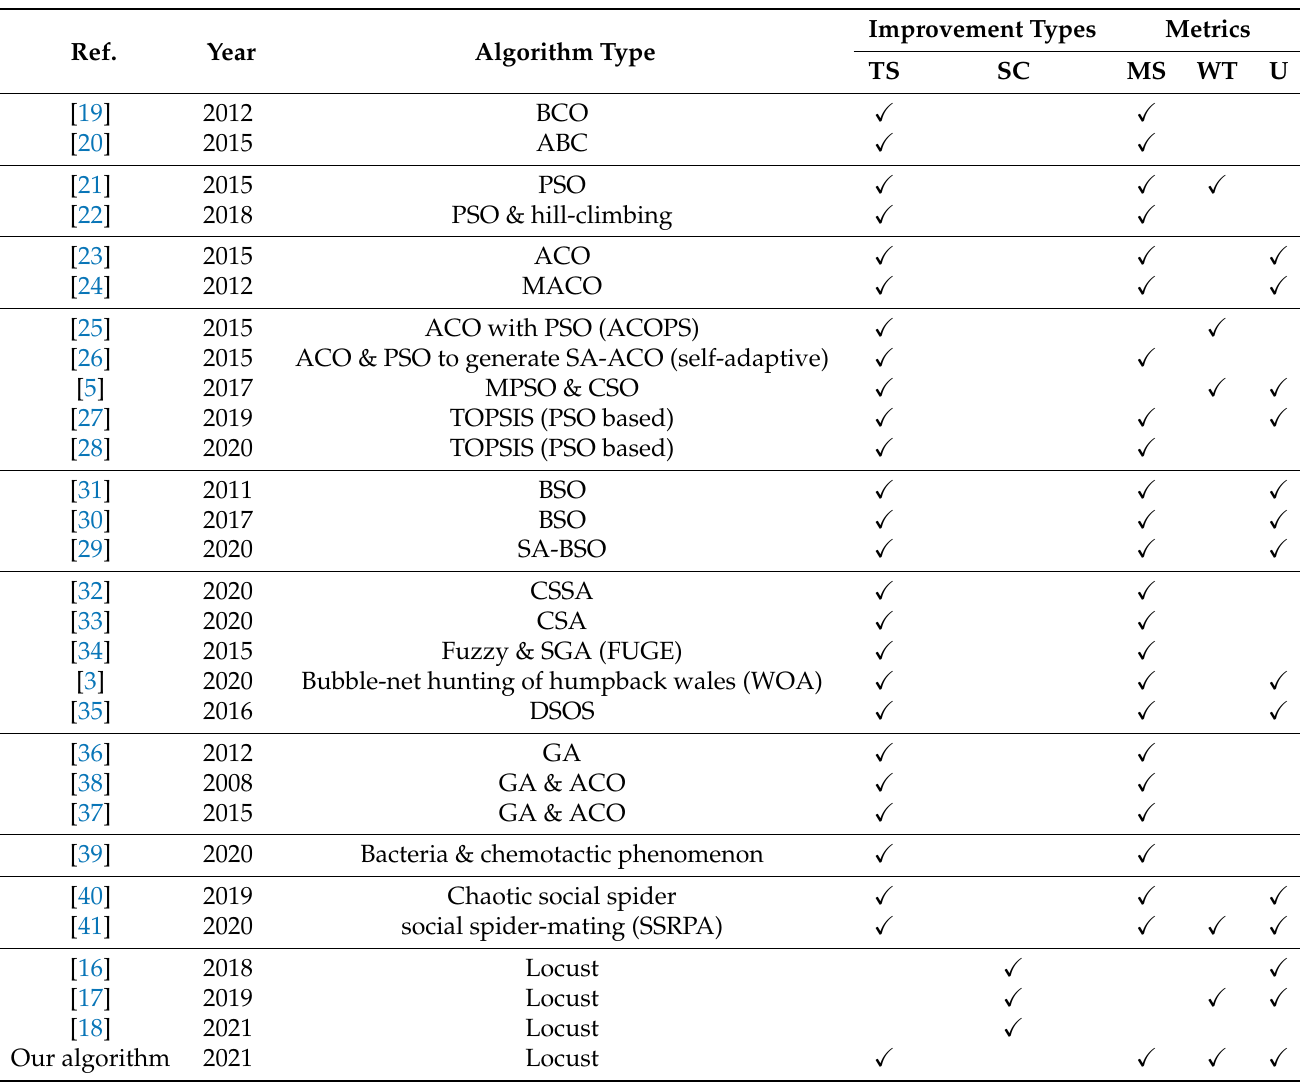
Table 1. Related work